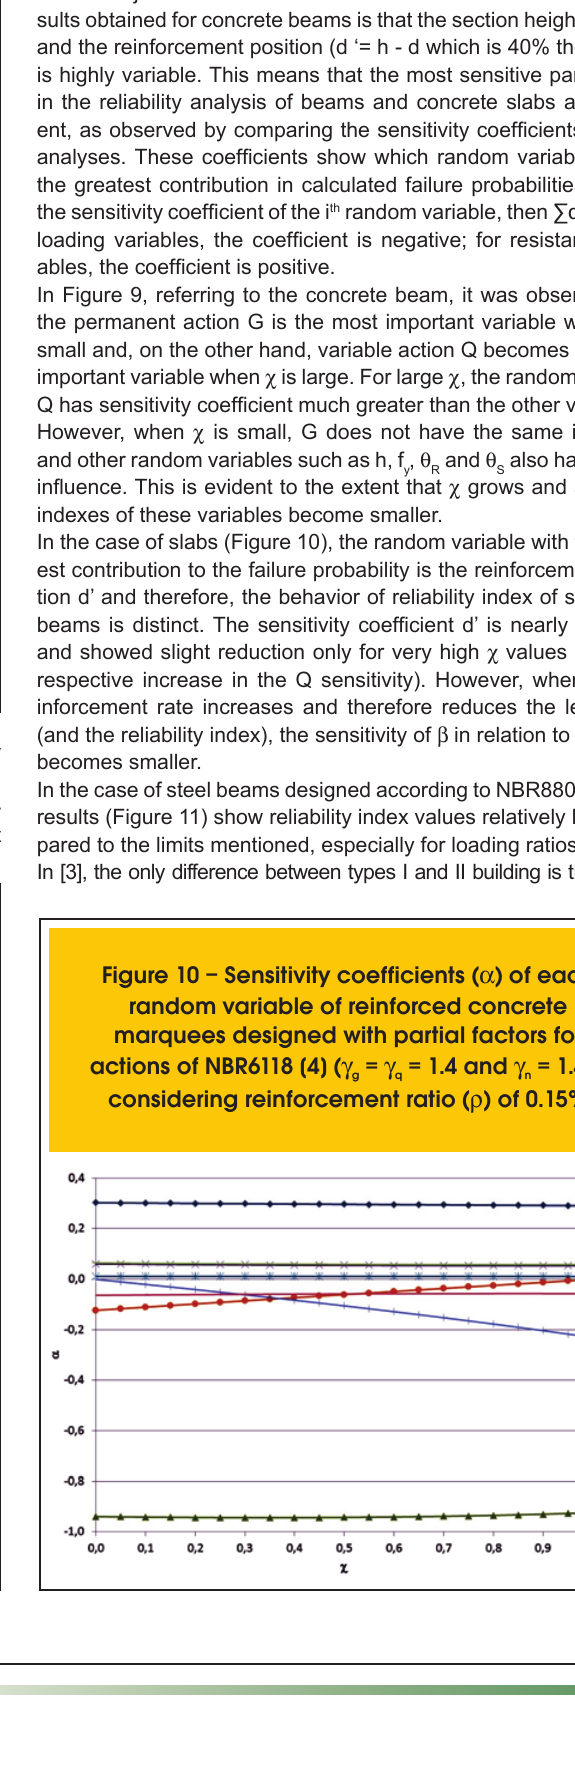
Figure 8 – Reliability indexes of reinforced concrete slabs designed